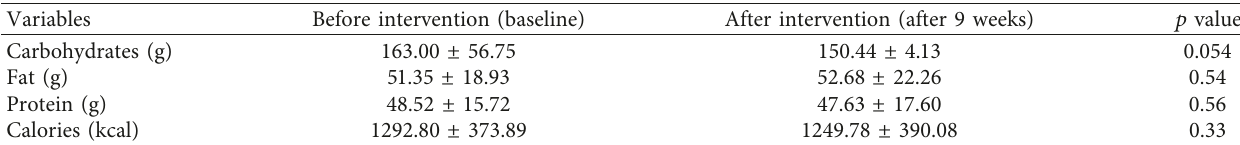
Table 2: Changes in macronutrient intake of the participants before and after intervention ( N � 52). Variables